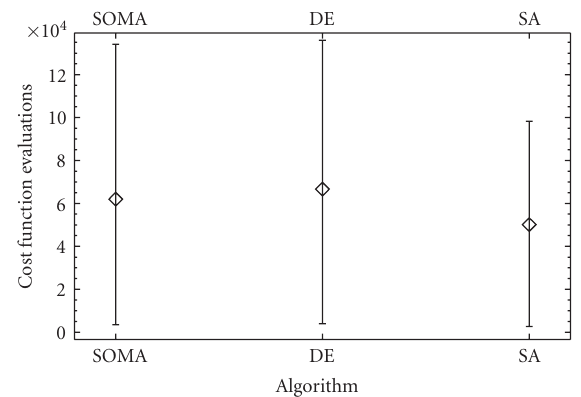
Figure 5: Graphical representation of minimal, maximal, and average values of cost function evaluation for SOMA, DE, and SA.